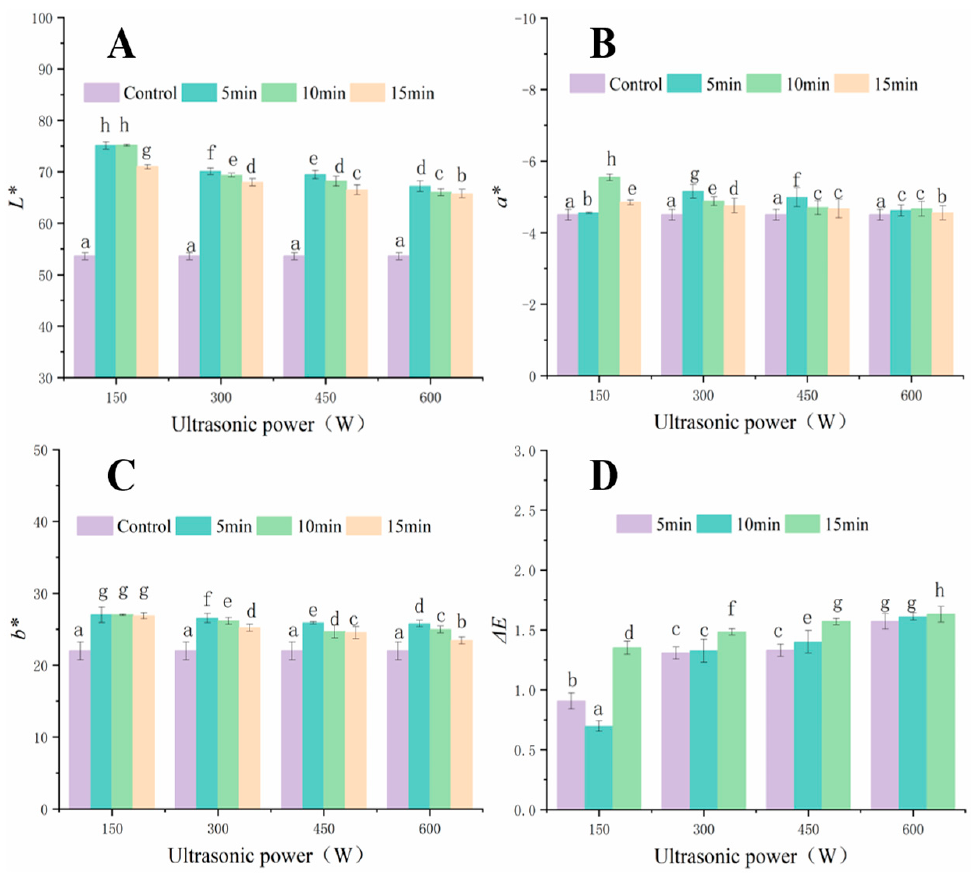
Figure 3. Changes in L ( A ), a* ( B ), b* ( C ) , and ∆ E ( D ) for the colour difference in FSI powders obtained by selected differences in ultrasonic power of UAVD. Different letters in the histogram indicate that the extraction time points within UAVD are signif-icantly different ( p < 0.05).